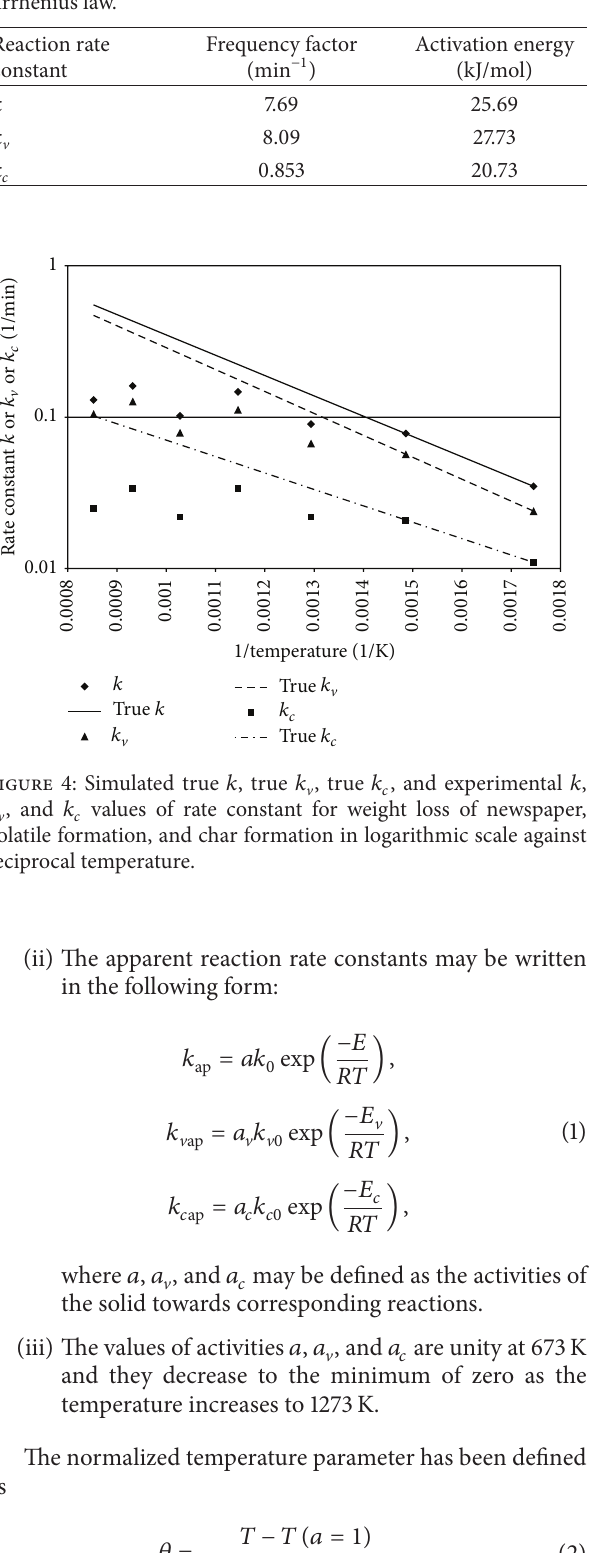
Table 3: Values of constant for deactivation